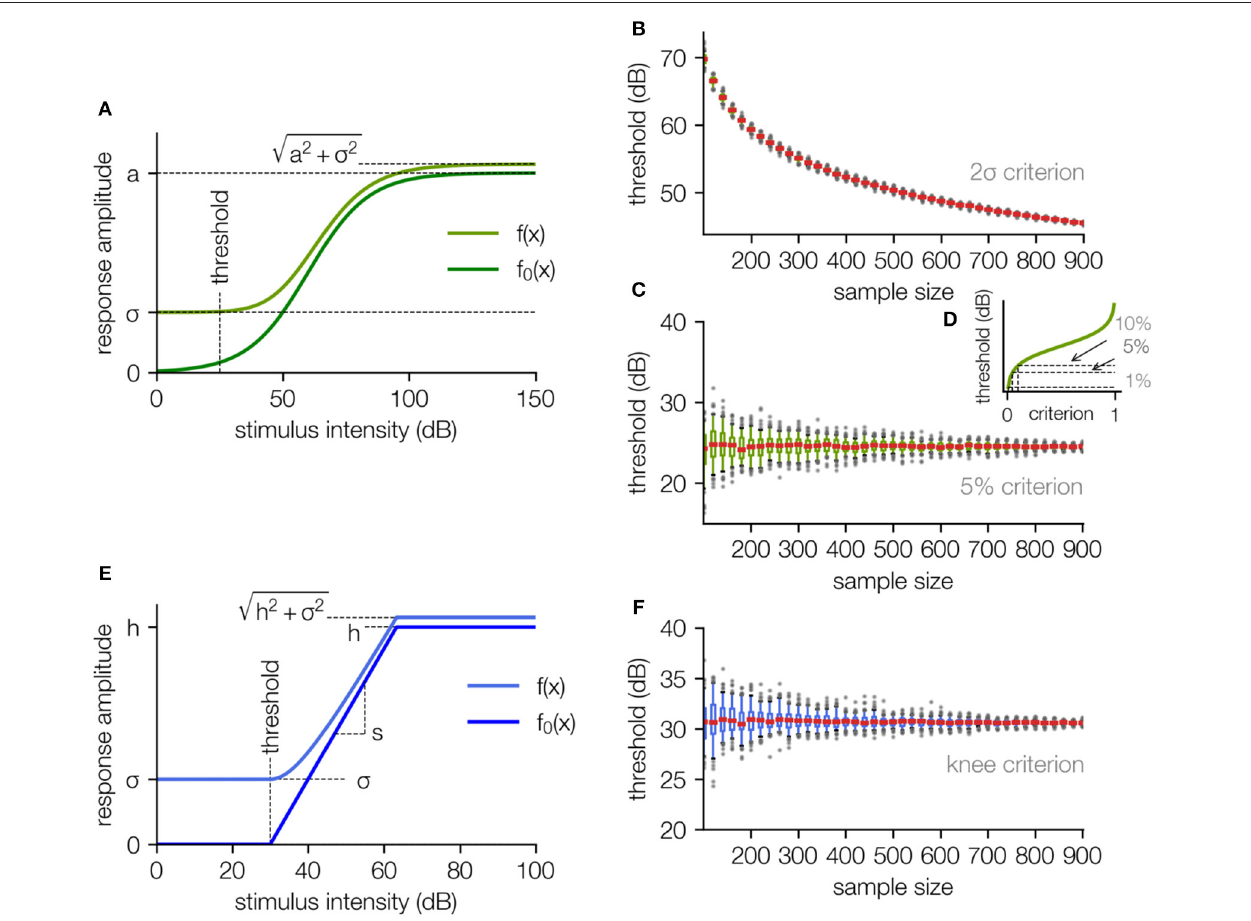
FIGURE 2 | The fit function based on a generalized logistic function. (A) The stimulus response function without background noise is approximated using a generalized logistic function (dark green). The fit function (light green) is the square root of the sum of the squared “pure” neuronal signal and the squared noise amplitude (including neural noise and measurement noise, for the derivation cf. Supplementary 2 ). (B) The estimated threshold for the 2 σ -criterion as a function of the number of applied data samples decreases monotonically with rising sample size and diverges to for an infinite number of samples. (C) The estimated −∞ threshold for the 5% criterion is independent of the sample size, only the uncertainty decreases (estimated by subsampling, cf. Methods). (D) Different choices of the threshold parameter p for this criterion result in different threshold estimates. (E) To get rid of the arbitrary parameter p, the sigmoid shape of the stimulus response function can be approximated with a hard sigmoid function (dark blue), where the threshold is defined as the lower knee. In analogy to the logistic function, for fitting the responses the function is superimposed with a noise offset sigma. (F) Estimated threshold for the knee criterion as a function of the sample size. The small constant offset compared to the analysis in (C) is caused by the arbitrary parameter p used for the 5% criterion. The analysis in (B,C,F) was performed by stepwise subsampling with increasing sample size N, with 100 subsamples for each